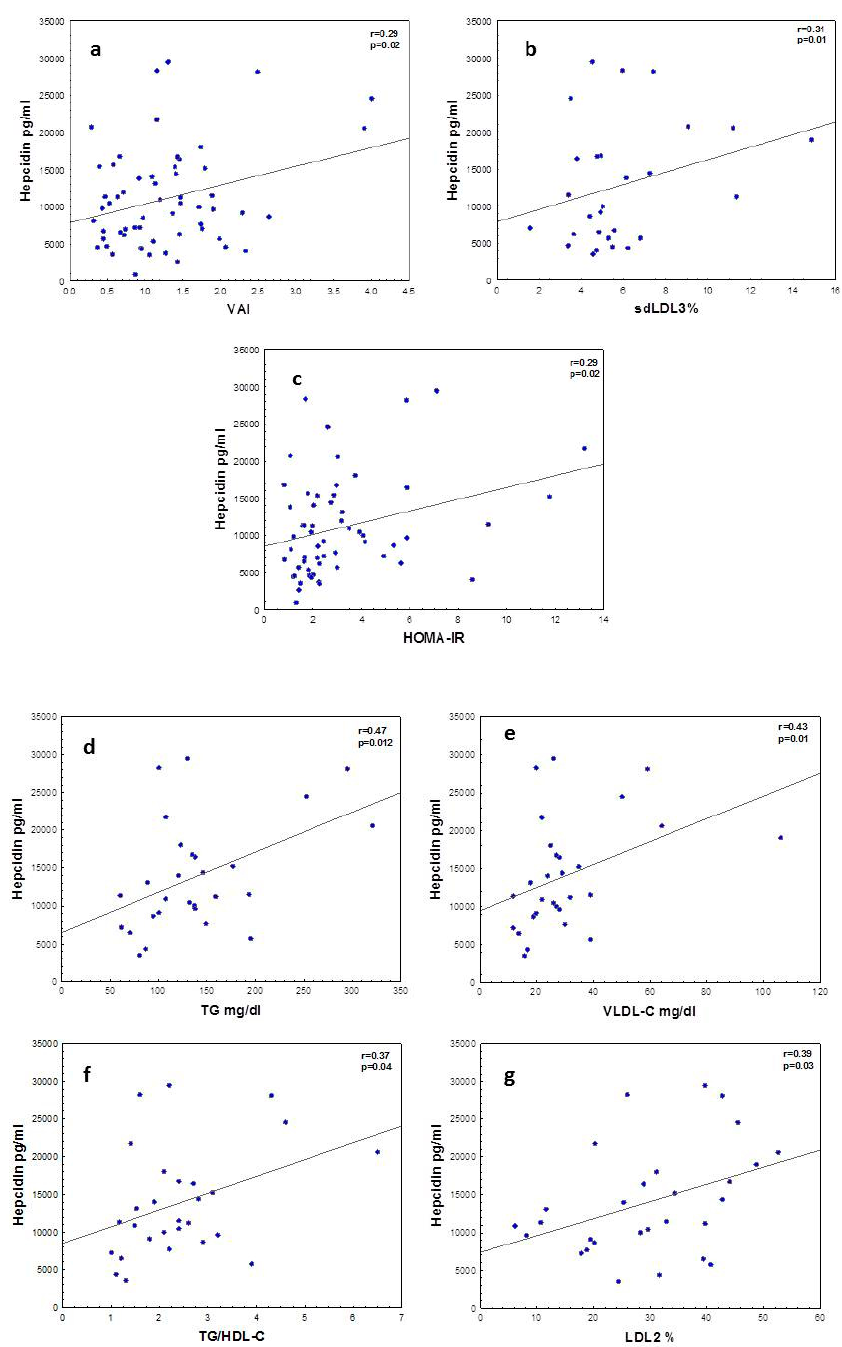
Figure 1. Correlations between hepcidin, insulin resistance and lipid metabolism. ( a ) Hepcidin vs. visceral adipose index (VAI), ( b ) hepcidin vs. small LDL (sd-LDL), ( c ) hepcidin vs. HOMA-IR, ( d ) hepcidin vs. TG, ( e ) hepcidin vs. VLDL-C, ( f ) hepcidin vs. TG/HDL-C and ( g ) hepcidin vs. smaller LDL2. Correlations among variables with normal distributions are shown as Pearson’s correlation coefficients and for variables with skewed distribution Spearman’s correlation coefficients are